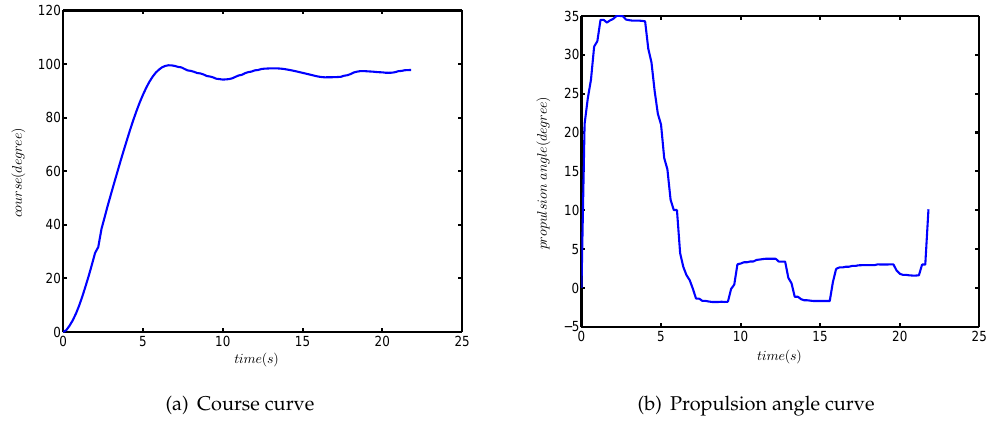
Figure 13. The field experiment for course